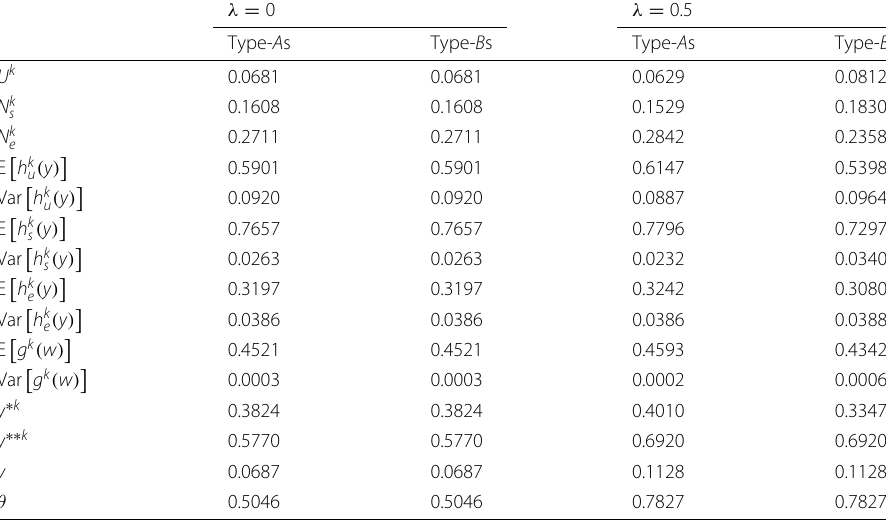
Table 6 Outcomes in the baseline model